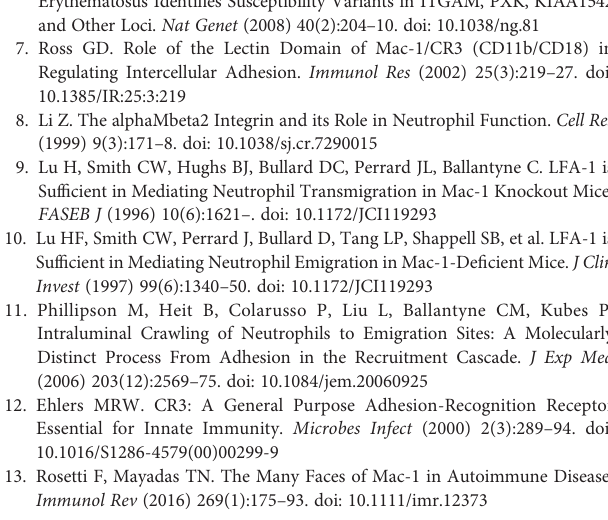
assessment of CD11b expression on splenic neutrophils (CD11b + Ly6G + ) of the indicated mice at 12-, 24- and 36-weeks of age; (B) Representative histopathology depicting glomeruli of the indicated 36-week-old mice with quantitation of glomerular cross-sectional area. For (A) , histograms are representative, and data are derived from n = 7-12 per group, pooled from 3-4 experiments per time-point. The CD11b-ve histogram was derived by gating on the population of C57BL/6 cells that do not express CD11b. For (B) , images are representative offour experiments and data are of n = 8-11 per group. **p < 0.01, ***p < 0.001 by Dunn ’ s multiple comparisons test and #### p < 0.0001 by Mann-Whitney U test. Supplementary Figure 2 | The B cell compartment in Lyn -/- Itgam -/- mice is unchangedfromthatin Lyn -/- mice.Spleensfrom24-week-oldmiceoftheindicated genotypes were assessed by fl ow cytometry for: (A) populations of B cells (B220+CD138-) and plasma cells (CD138+B220-) cells; (B) numbers of B cells with (C) proportions offollicular (Fol.; CD23 + CD21 low ),marginal zone (MZ; CD21 + CD23 - ) and transitional stage 1-3 (T1-3; CD23 - CD21 - ) subsets; (D) numbers of plasma cells, and relative surface expression of (E) IgM and (F) Fc g RII on plasma cells. Flow plots in (A) are representative of three experiments. For data in (B-F) , n = 7-12 per group, pooled from three experiments. *p < 0.05, **p < 0.01, ***p < 0.001, ****p < 0.0001 by Dunn ’ s multiple comparisons test and # p < 0.05, ## p < 0.01 by Mann- Whitney U test. Supplementary Figure 3 | Kidney fl ow cytometry gating strategy. Perfused and digestedkidneysfrom24-week-oldmiceoftheindicatedgenotypeswereassessed by fl ow cytometry for: (A) endothelial cells (CD45 - CD31 + EpCAM - ); leukocytes (CD45 + ); lymphocyte populations (CD45 + CD11b - CD11c - ) including: gd T cells (CD3 ϵ + gd TCR + ), CD4+ T cells ( gd TCR - CD3 ϵ + CD4 + ), CD8+ T cells ( gd TCR - CD4 - CD3 ϵ + CD8 a + ) and B cells ( gd TCR - CD3 ϵ - CD4 - CD8 a - CD19 + ); granulocyte populations (CD45 + CX3CR1 - F4/80 - ) including: neutrophils (Ly6G + SiglecF + ) and eosinophils (SiglecF + Ly6G - ); and phagocyte populations (CD45 + CX3CR1 + F4/80 + ), further subdivided in . Flow cytometric assessment of the expression of (B) adhesion molecules VCAM-1 and ICAM-1 on kidney endothelium and (C) integrins CD11a (LFA-1) and CD11c on kidney neutrophils. Flow plots in (A) are illustrative of gating strategy only, fl ow plots in (B, C) are representative of two experiments. Data in (A) are n = 5-9 per group and data in (B) are n = 6-9 per group, both pooled from two experiments. *p < 0.05, **p < 0.01 by Dunn ’ s multiple comparisons test and p value stated if approaching signi fi cance (p < 0.1), ## p < 0.01, by Mann-Whitney U test Supplementary Figure 4 | Immune complex deposition is not further enhanced by CD11b-de fi ciency in Lyn-/- mice. Immuno fl uorescence analysis and quanti fi cation of frozen kidney sections stained for glomerular IgG deposition. Images are representative and data is of n = 6-9 per group, scored blinded. **p < 0.01 by Dunn ’ s multiple comparisons